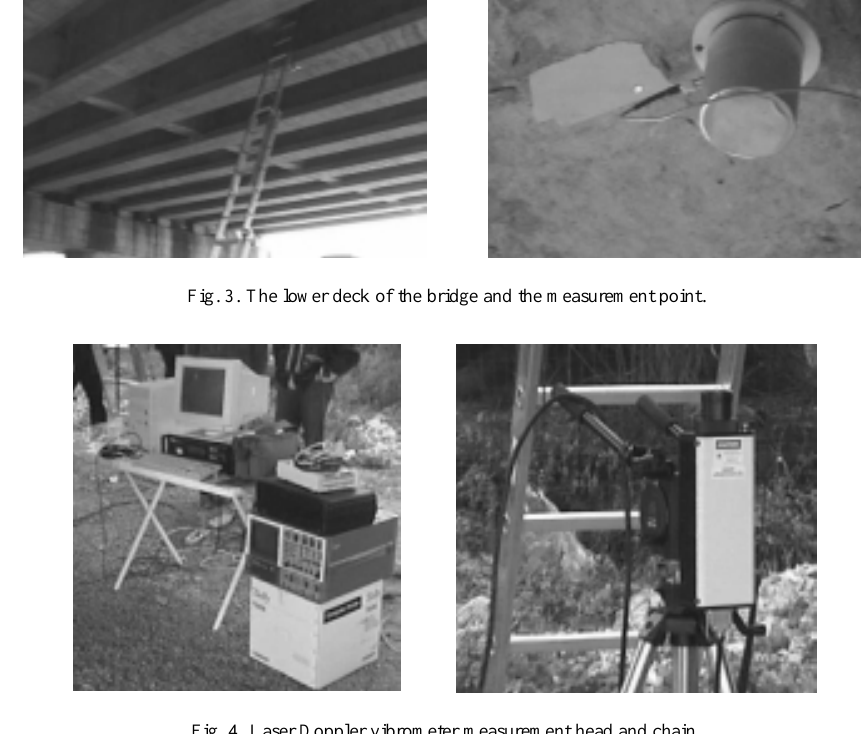
Fig. 4. Laser Doppler vibrometer measurement head and